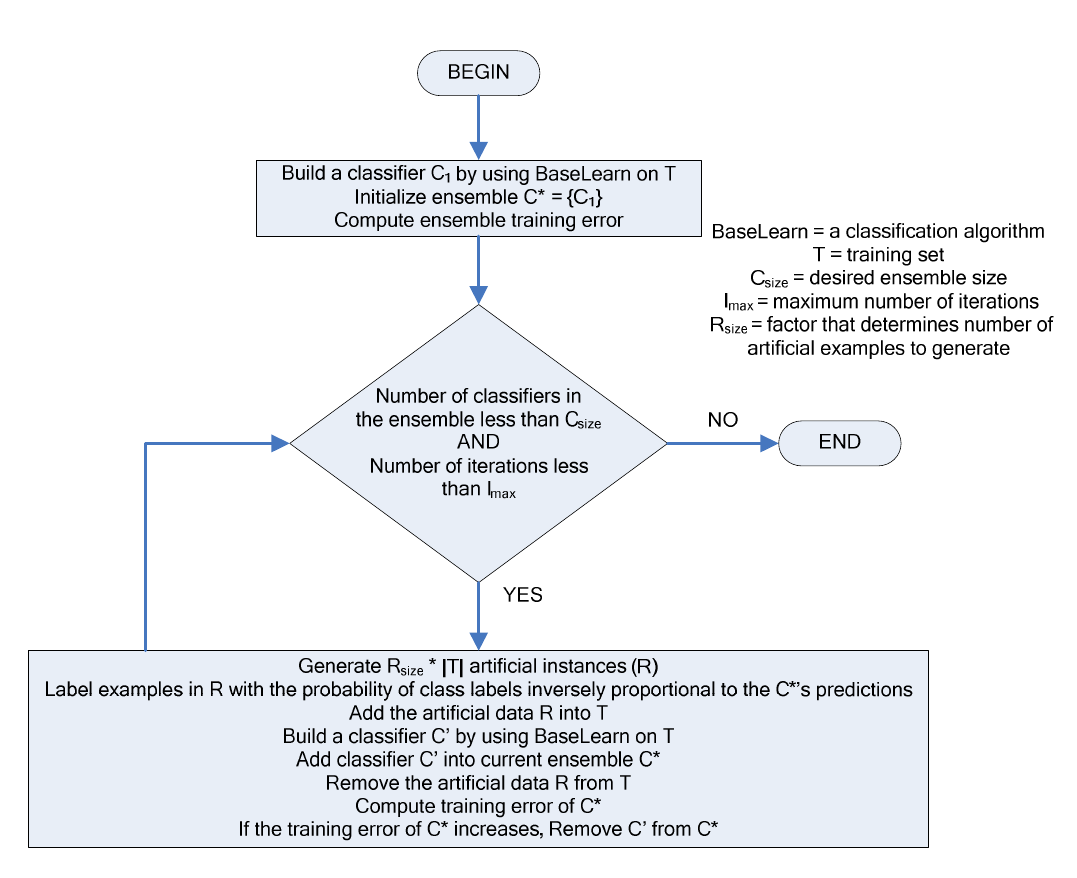
Figure 4. The diagram of the DECORATE